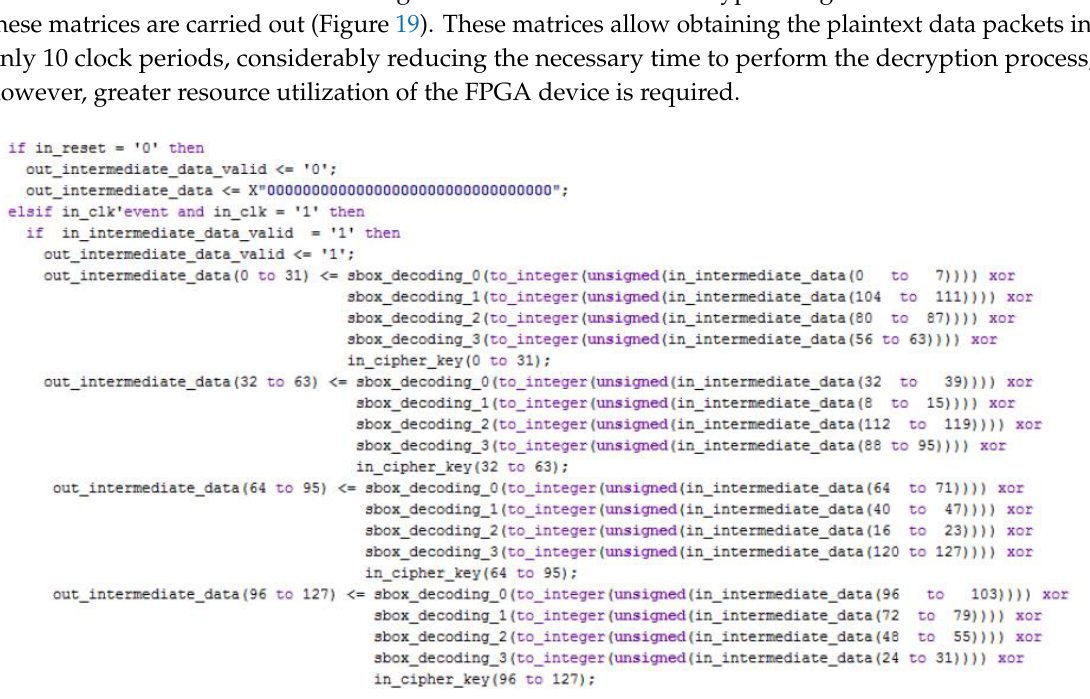
Figure 19. Code section related to the operation carried out during each round used to obtain the intermediate data and finally, the plaintext.